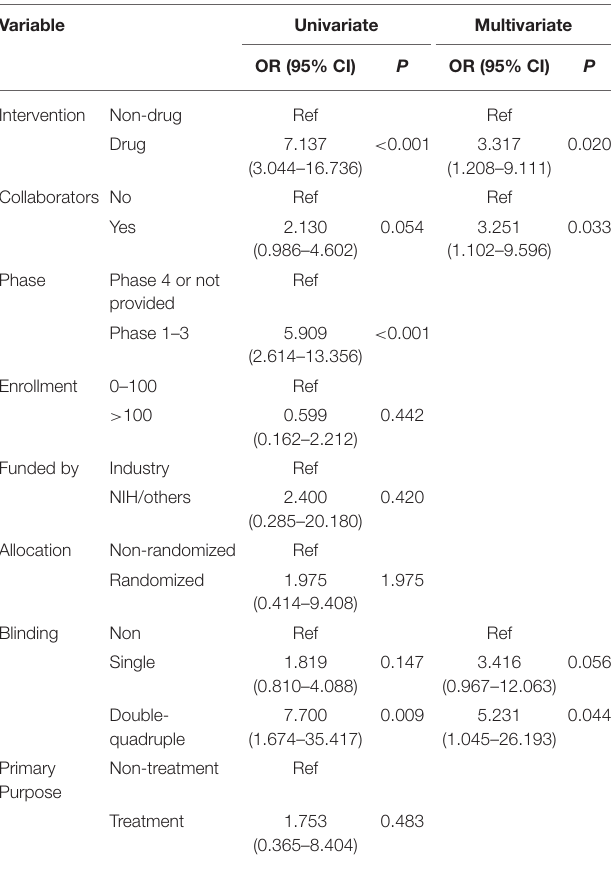
TABLE 4 | Logistic regression analysis of OCD trials characteristics associated with study results for completed trials.